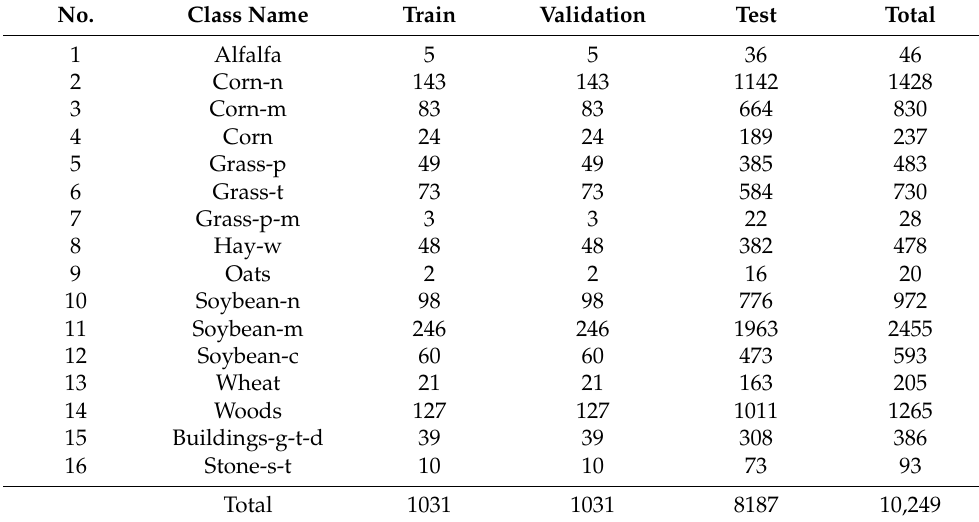
Table 1. Train, validation, and test split of IP